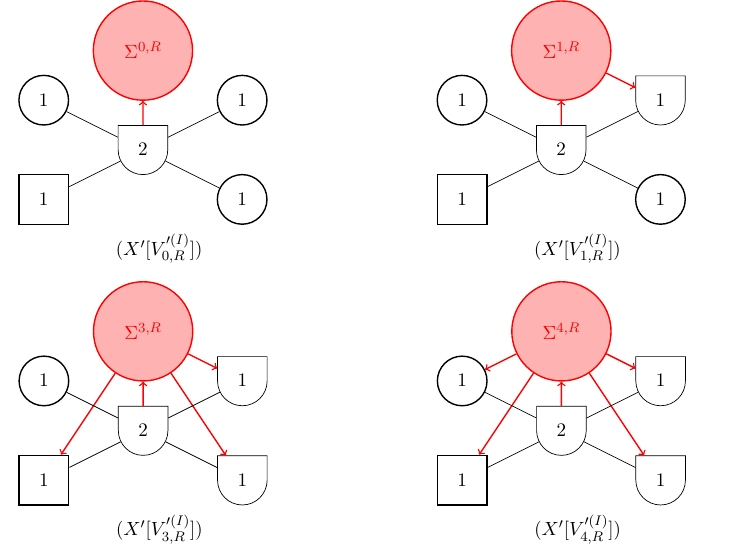
Figure 32 . The construction of vortex defects in the flavored D 4 quiver gauge theory X 0 , using an Abelian S -type operation from X [ V r ] with M = 0 , 1 , 3 , 4 M,R